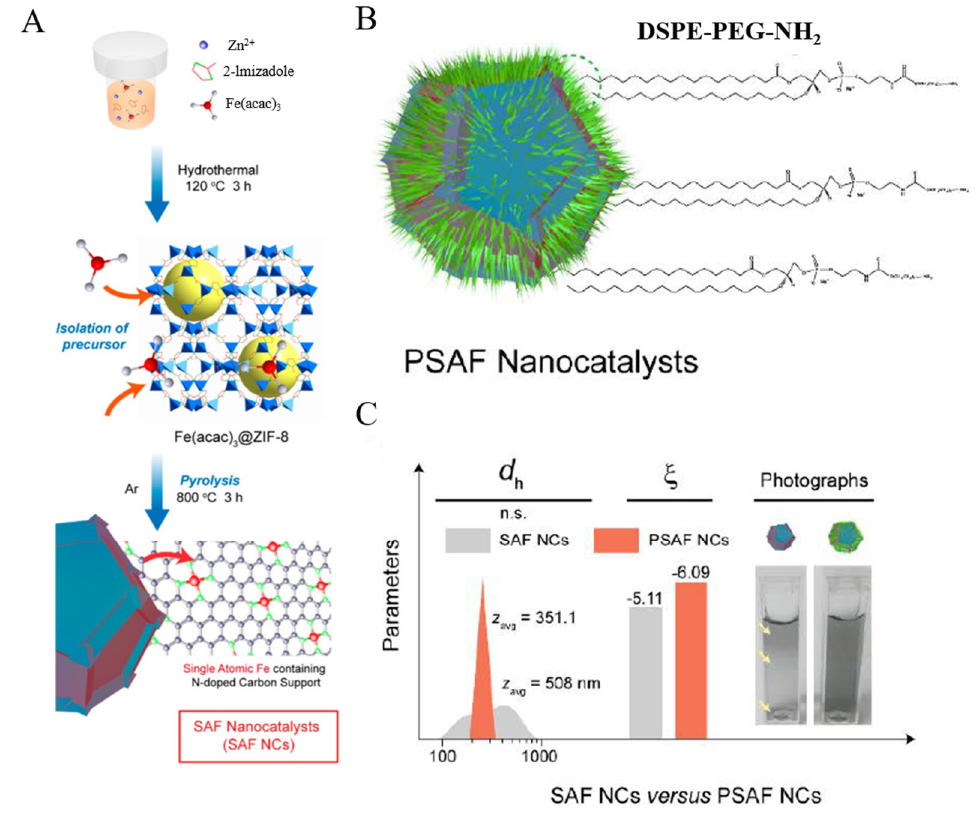
Figure 5. ( A ) Preparation of SAF NCs. ( B ) Structure of PSAF NCs. ( C ) Particle size distribution, zeta potential, and dispersibility in normal saline [86]. Copyright 2019, American Chemical